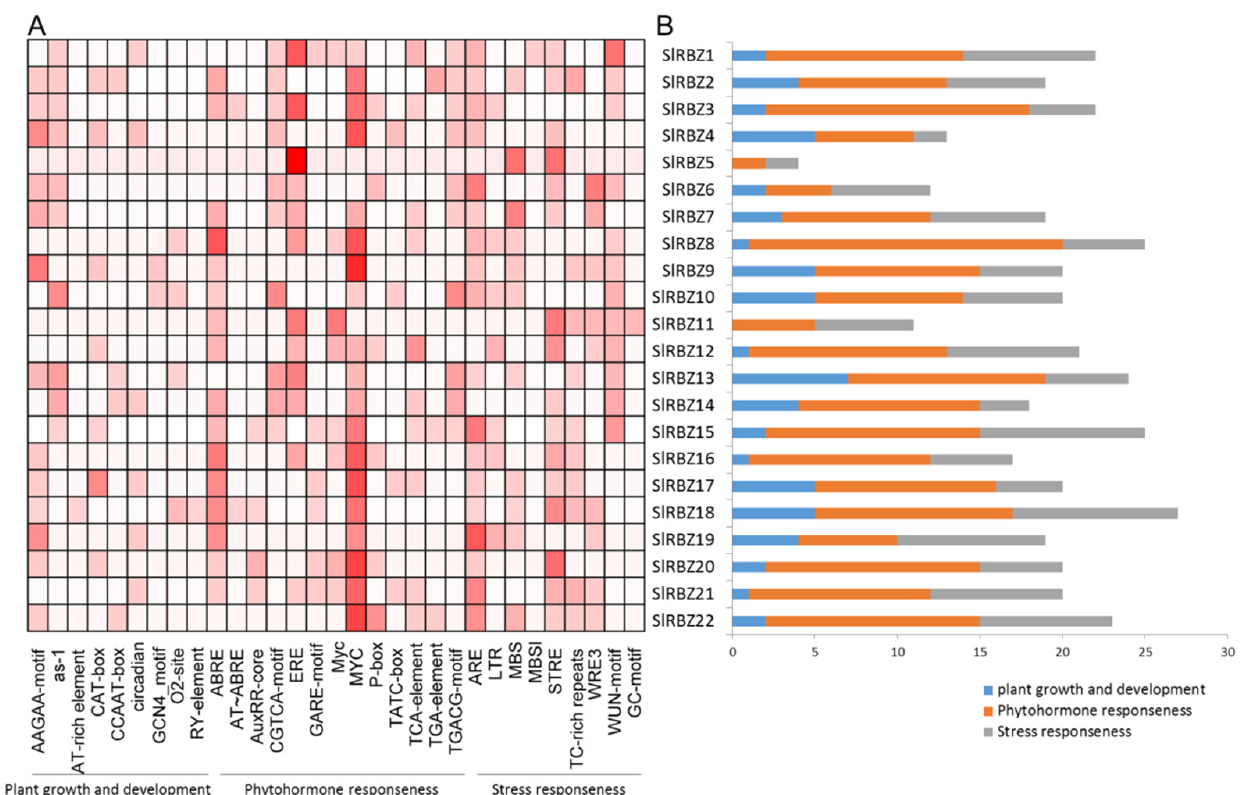
Figure 4. Information on cis-acting elements in the putative promoter regions of SlRBZs . ( A ) The gradient colors in the red grid indicate the numbers of cis-acting elements in the putative promoter regions of SlRBZs . ( B ) The X -axis shows the number of different types of cis-elements. The light responsiveness group, including Box 4, the TCT-motif, G-Box and GT1-motif, were found in most of the SlRBZ genes. LS7, the ATCT-motif and the AAAC-motif were located in SlRBZ9 , SlRBZ11 and SlRBZ22 , respectively. Additionally, we found 13 hormone responsiveness elements: ABRE (abscisic-acid (ABA)-responsive element); AT~ABRE and ERE (ethylene (ETH)-responsive elements); the CGTCA-motif and TGACG-motif (jasmonic-acid (JA)-responsive elements); TCA-element (salicylic-acid (SA)-responsive elements); GARE-motif, P-box and TATC-box (gibberellin (GA)-responsive elements); AuxRR-core and TGA-element (indole-3-acetic acid (IAA) responsiveness); and MYC and Myc, as displayed in the Supplementary Materials, Table S3. These results suggest that the transcription levels of the SlRBZ genes may be induced by these hormones. Furthermore, nine stress responsiveness elements were found, including MBS (drought inducibility), TC- rich repeats, MBSI and STRE (stress), ARE and GC-motif (anaerobic induction), LTR (low temperature), and WUN-motifs and WRE3 (wound responsiveness). In the plant growth and development group, some cis-elements are responsible for tissue-specific expressions, such as CAT-box in meristem cells, RY-element in the seeds, HD-Zip 1 in palisade mesophyll cells and GCN4 motif in the endosperms. These results indicate that SlRBZ genes might be involved in the complex regulatory networks during plant growth and